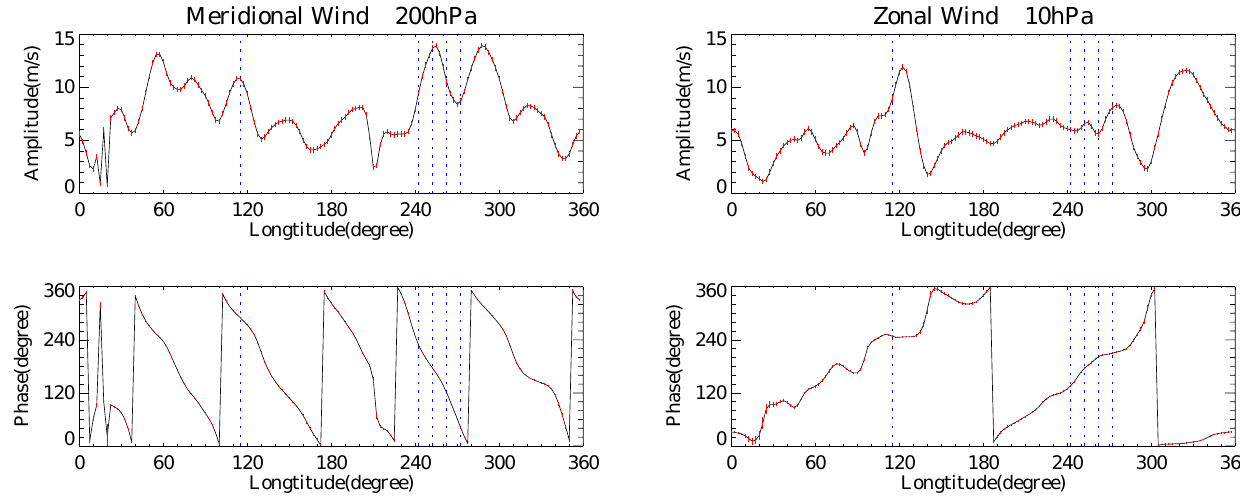
Fig. 10. The harmonic fitting results for the quasi 16-day waves of meridional wind disturbance at 200hPa and latitude 32.5 ◦ N during 15 January 2001 to 15 February 2001. The blue dotted lines in every panel denote the positions of Wuhan, Miramar Nas, Santa Teresa, Fort Worth and Birmingham from left to right. The red lines in every 2.5 ◦ in longitude denote the error bar.